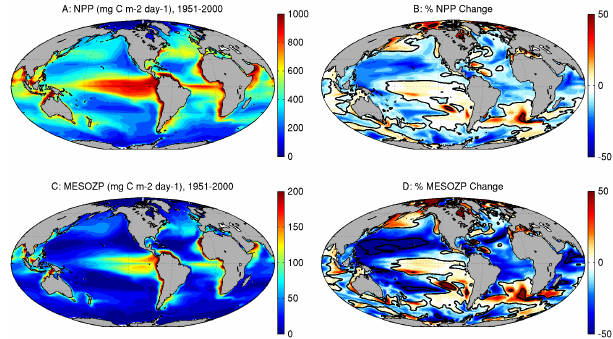
Figure 3. Contemporary (1951–2000) NPP and MESOZP (a, c) and percent changes between 2051–2100 and 1951–2000 (b, d) . For regions with NPP >25mgCm − 2 day − 1 in 1951–2000 (see meth- ods), the correlation between MESOZP change and NPP change is 0.86 and the magnitude of MESOZP changes is 2.1 times the NPP change. Contours are shown at − 50, 0 and +